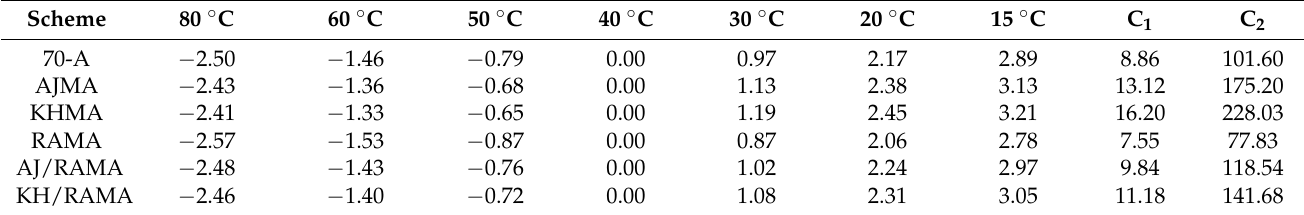
Table 5. Shift factors and test parameters of the six asphalt